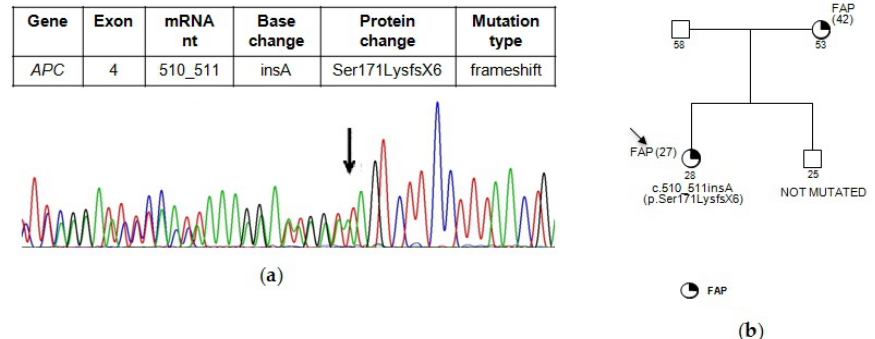
Figure 1. ( a ) Partial electropherogram of APC exon 4. The novel mutation identified c.510_511insA